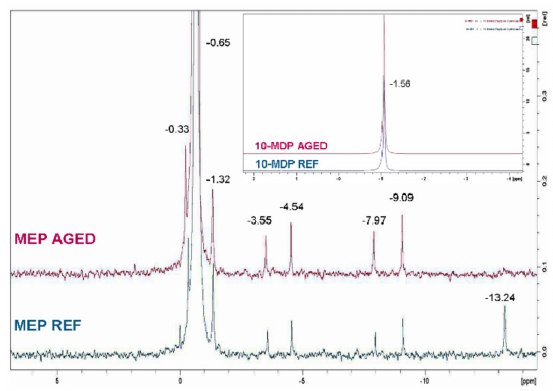
Figure 2. 31 P-NMR spectra of MEP and 10-MDP control (insert) before and after